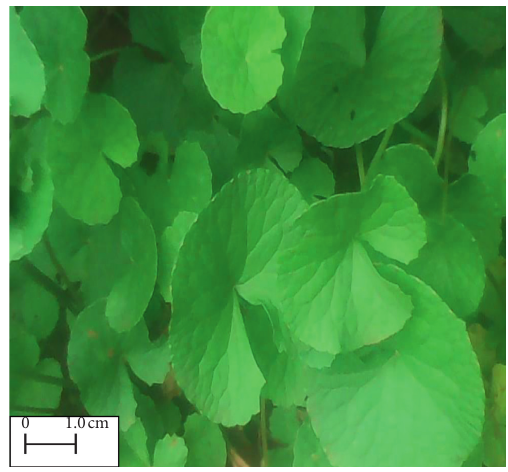
Figure 1: Picture of Centella asiatica